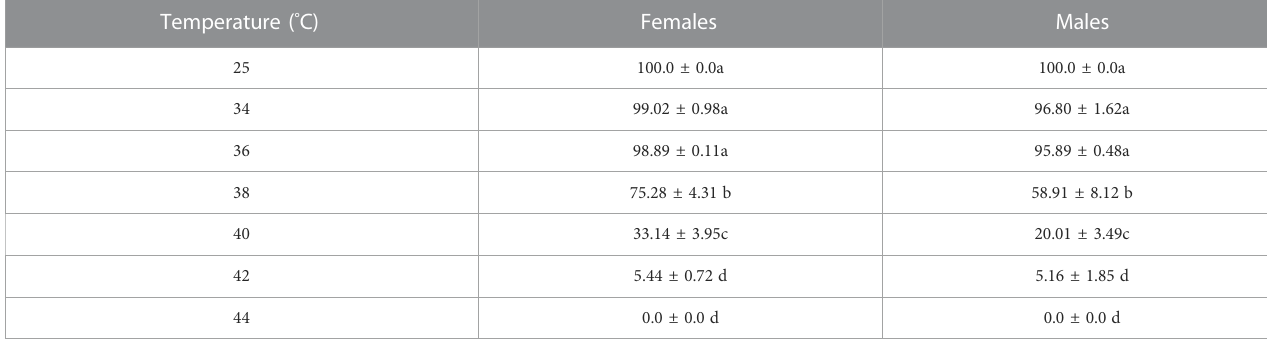
TABLE 1 The survival rate of Z. tau adults exposed to different high-temperature treatments for 12 h.